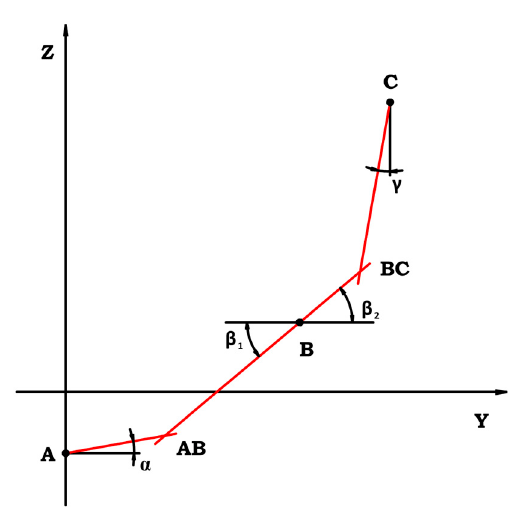
Figure 9. Control polygon of a G1 second-degree rational Bézier curve.